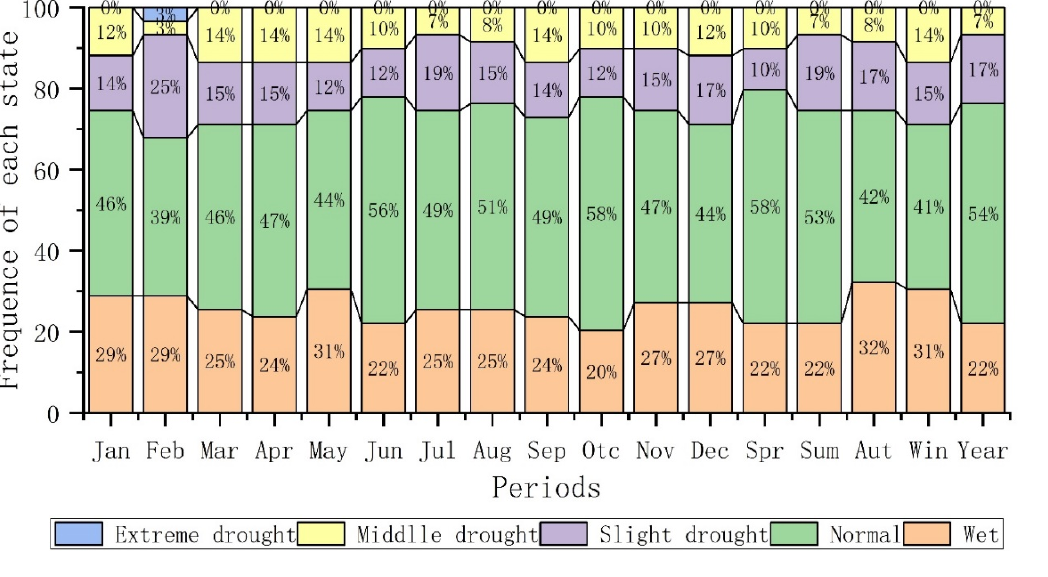
Figure 6. The frequency of different states in different periods from 1960 to 2019. The Spr, Sum, Aut, and Win was represented the spring, summer, autumn, and winter, respectively.